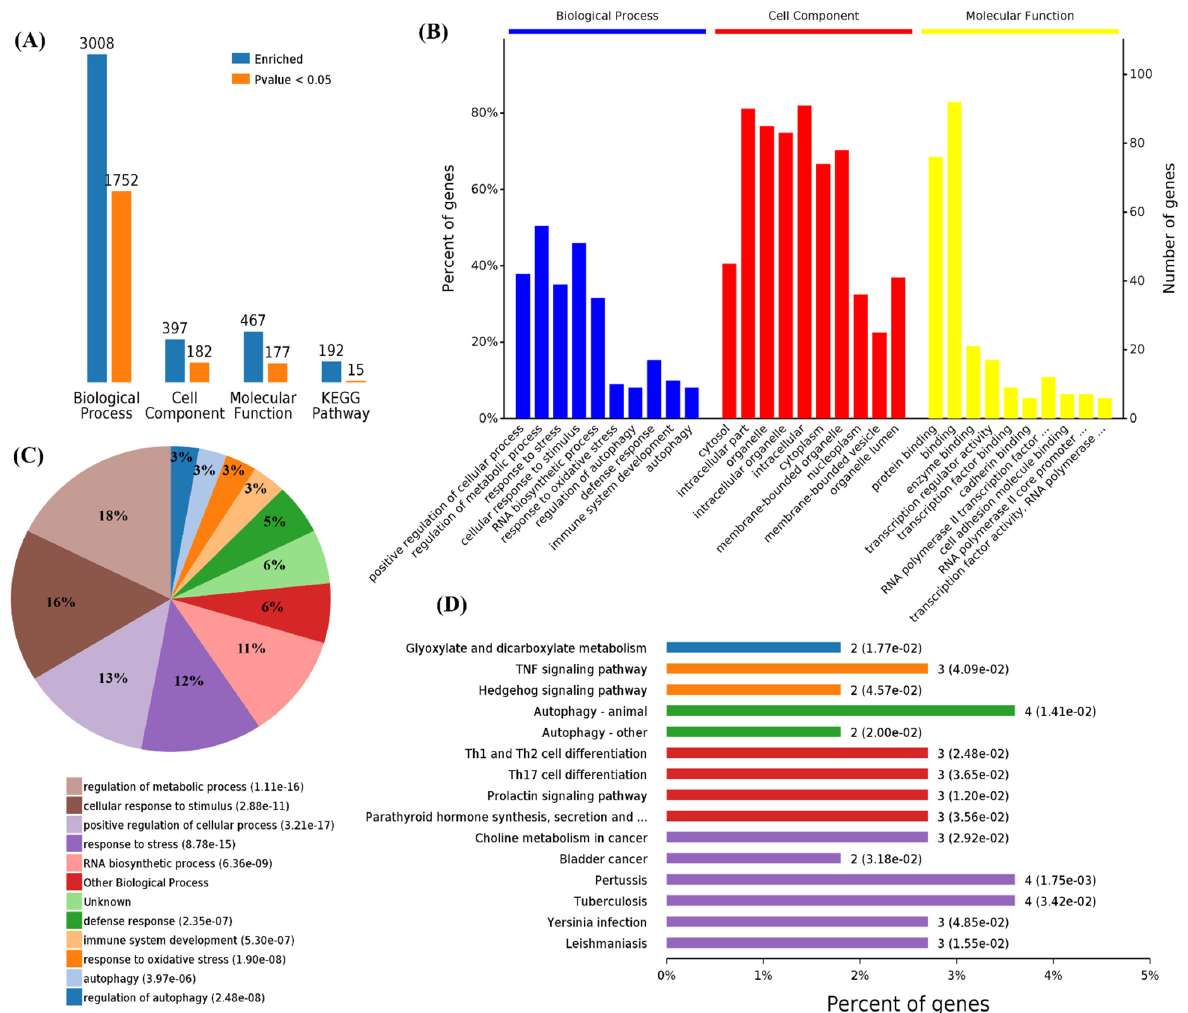
Figure 2. Functional enrichment of the 114 commonly upregulated mRNAs among infected groups. ( A ) Number of commonly differentially expressed genes enriched in GO terms and KEGG pathways. ( B ) Overview of significantly enriched biological process, cell component, and molecular function of the commonly upregulated genes. ( C ) Pie chart of an enriched biological process of the commonly upregulated genes. ( D ) Percentage of commonly upregulated genes associated with enriched KEGG pathways.